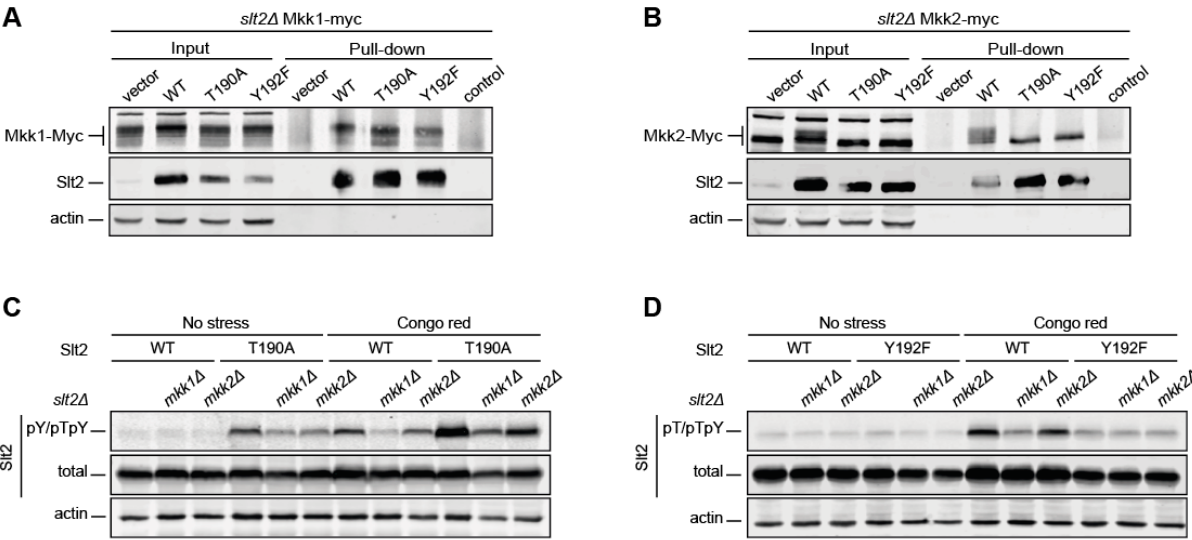
Figure 3. Analysis of Mkk1 and Mkk2 binding to differentially phosphorylatable forms of Slt2 and their effect on Slt2 phosphorylation. The strains slt2 ∆ MKK1-myc (YMJ30) ( A ) and slt2 ∆ MKK2-myc (YMJ31) ( B ) were transformed with the plasmid pRS316 alone (vector) or expressing, as indicated, Slt2 (WT), Slt2 T190A , or Slt2 Y192F . Cells were grown to the mid-exponential phase in YPD and then stimulated with 30 µ g/mL of Congo Red (CR) for 2 h. Cell extracts (input) were incubated with the Mpk1 antibody attached to Dynabeads™ Protein G to purify Slt2 complexes (pull-down) and resolved by SDS–PAGE. Proteins were detected with anti-c-Myc, anti-Mpk1 (Slt2), and anti-actin antibodies by immunoblotting. The control of a Dynabeads-Mpk1 antibody non-incubated with cell extracts is included. ( C , D ) slt2 ∆ (Y00993 strain), mkk1 ∆ slt2 ∆ (YGGR32 strain), and mkk2 ∆ slt2 ∆ (YGGR33 strain) cells containing the same plasmids as in (A,B) were grown